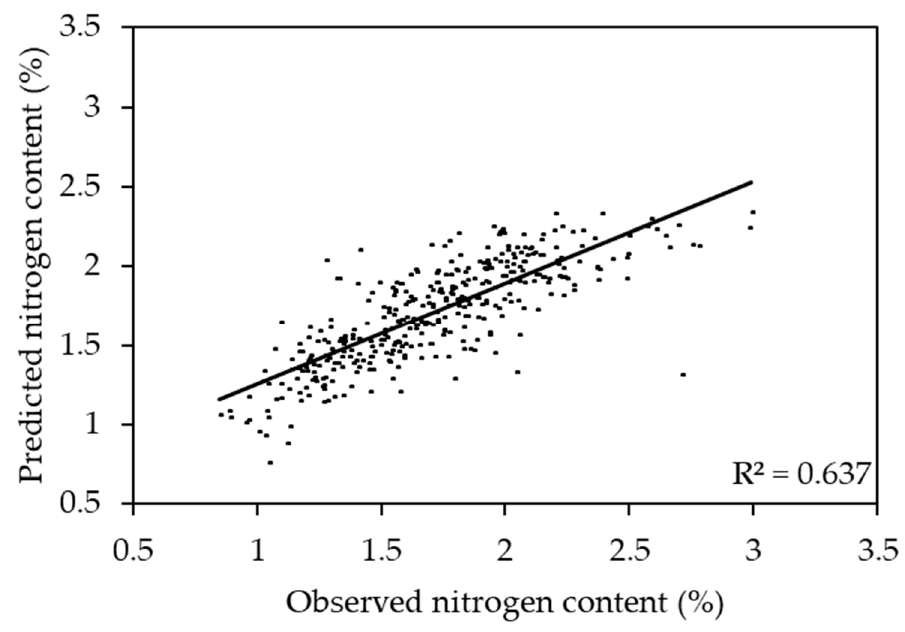
Figure 6. Scatter plot of observed vs. predicted nitrogen content using the sorghum- and corn-based model.